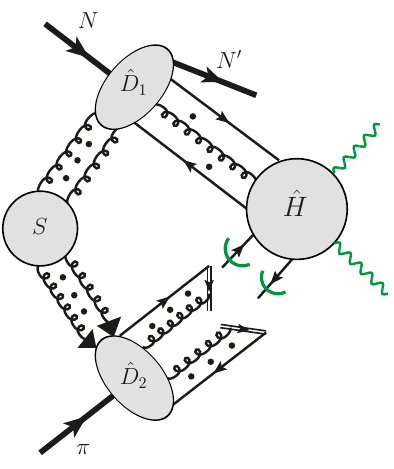
Figure 16. The result of using Ward identity for ˆ D 2 -collinear gluons. The Wilson lines point along w 1 to the past. The notations are similar to figure